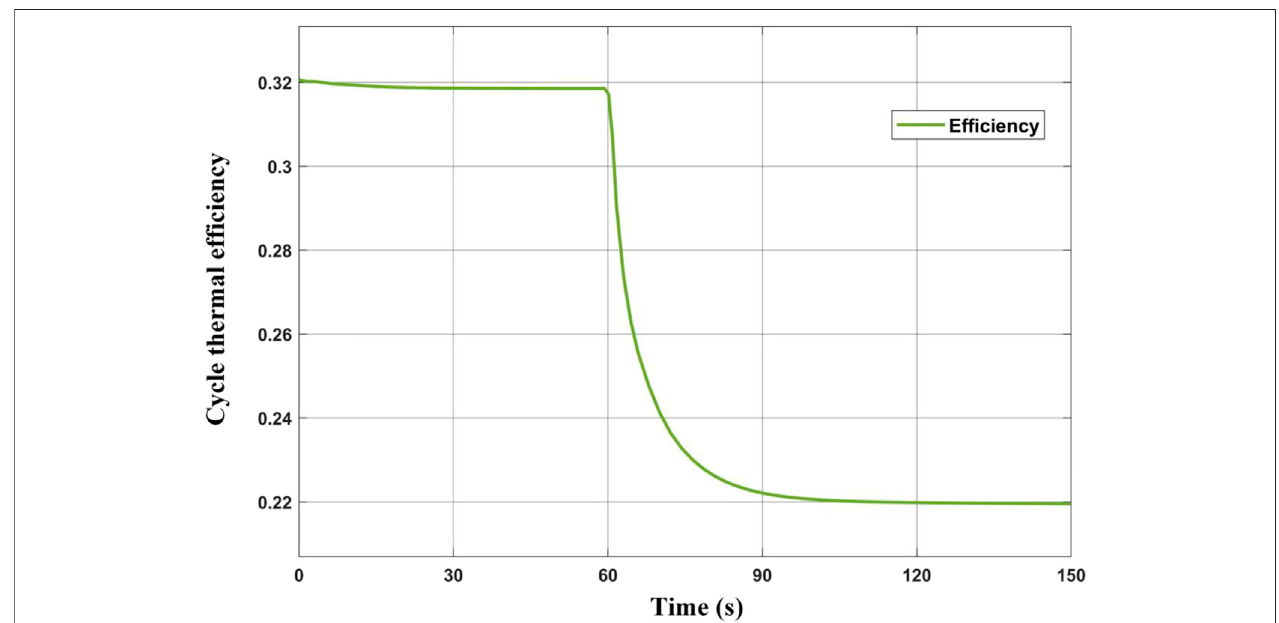
FIGURE 6 | Dynamic response of system thermal ef fi ciency while reducing heat source power.